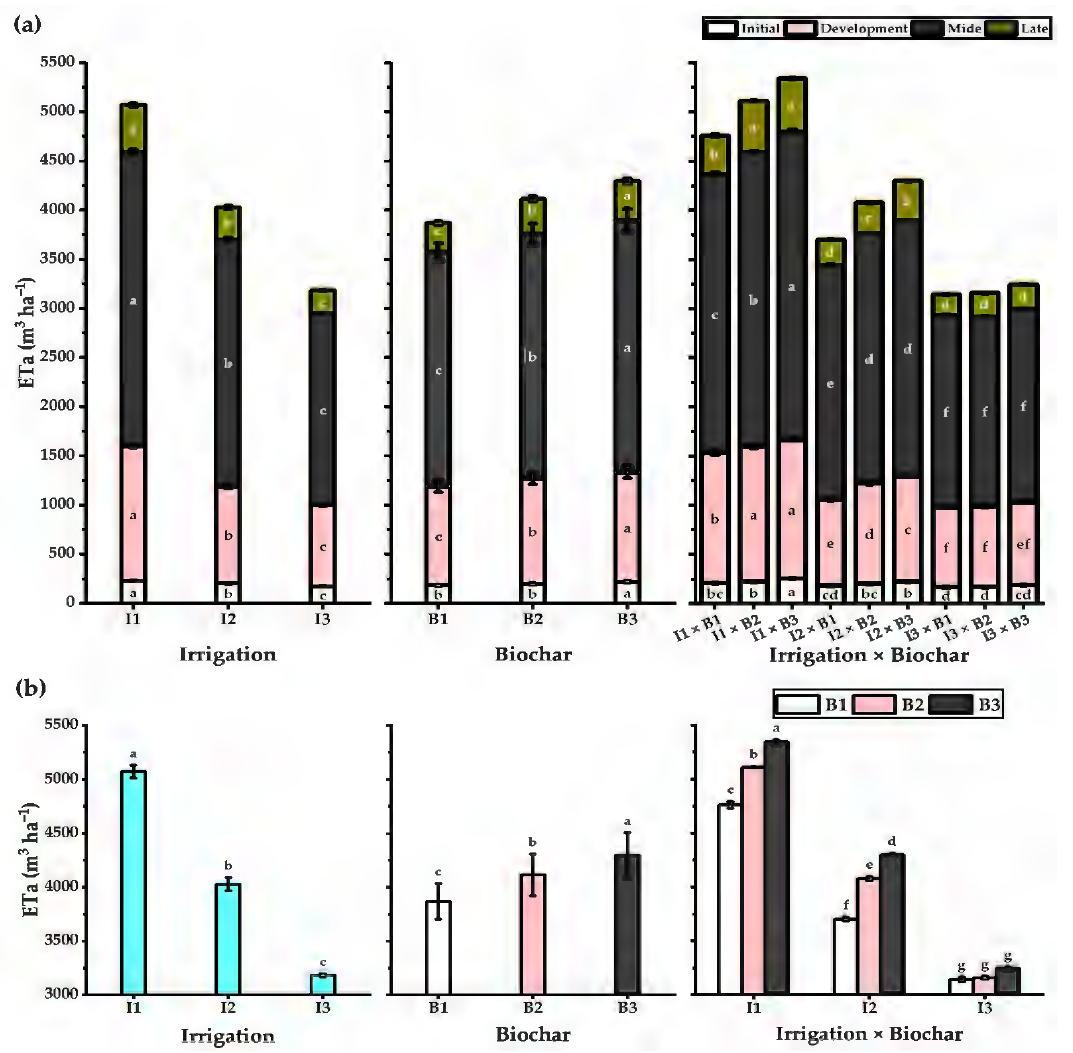
Figure 1. Actual evapotranspiration (ETa) for different growth stages ( a ) and total ETa ( b ) of the wheat plants affected by three irrigation levels of 100 (I1), 80 (I2), and 60% (I3) of crop evapotranspiration (ETc), and three levels of biochar soil supplementation 0 (B1), 7.5 (B2), and 15 t ha − 1 (B3). Bars and error bars represent the means ± SE, respectively, of three biological replicates. Different letters reveal statistically significant differences among